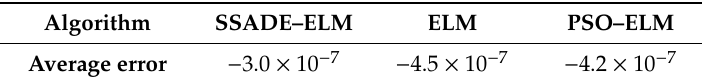
Swarm Optimization–ELM).